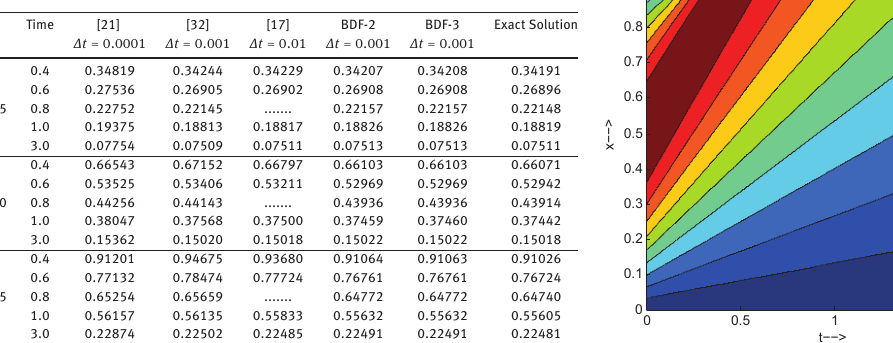
Table 5: Comparison with different numerical methods and exact solution of Example 1 for ν = 0.01 .